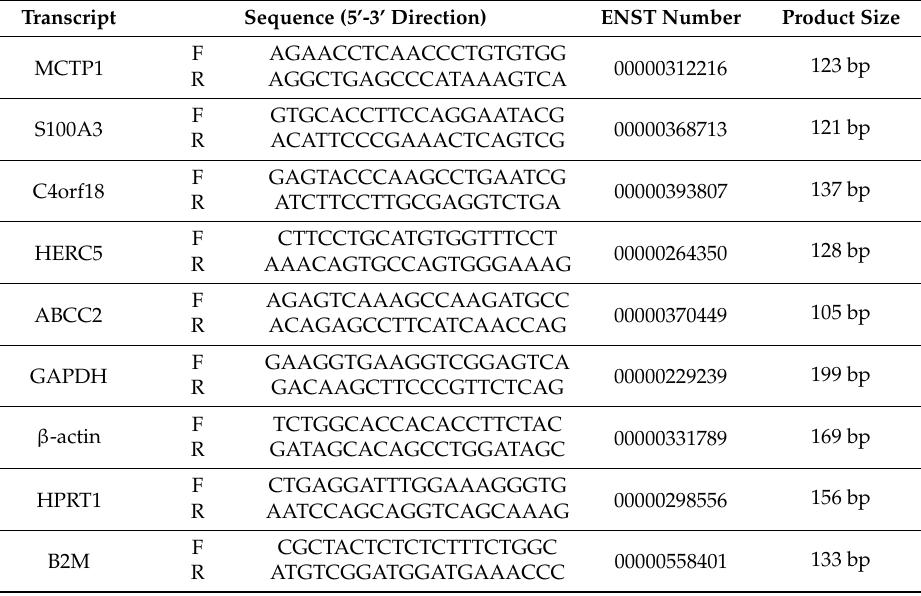
Table 1. Oligonucleotide sequences used for RQ-PCR